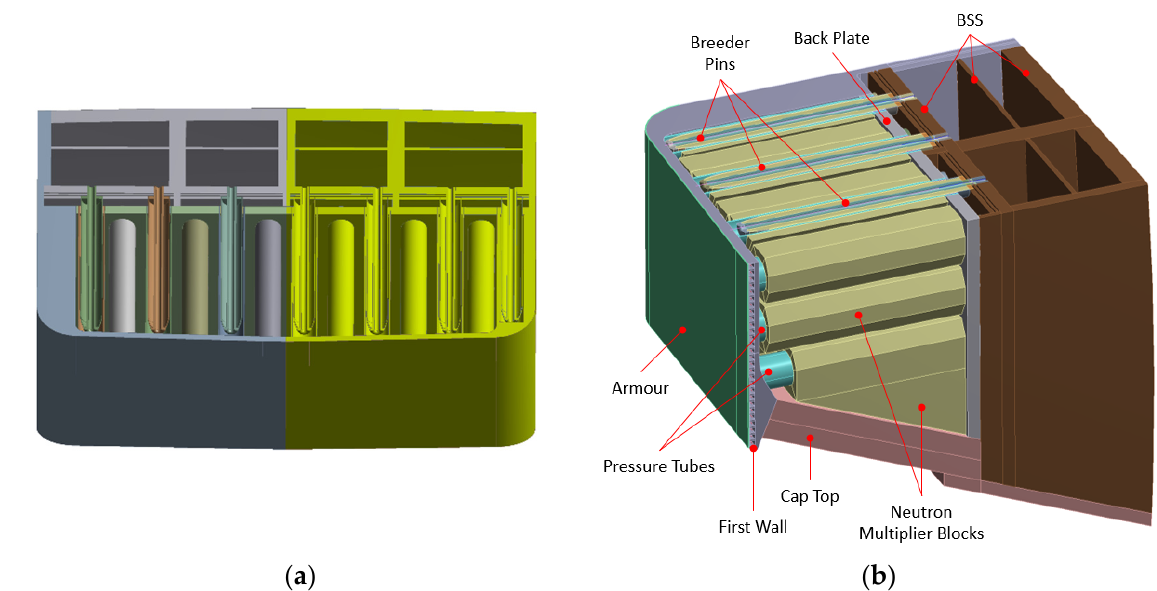
Figure 2. ( a ) HCPB BB cap region with highlighted symmetry section. ( b ) Symmetry section considered for simulation.